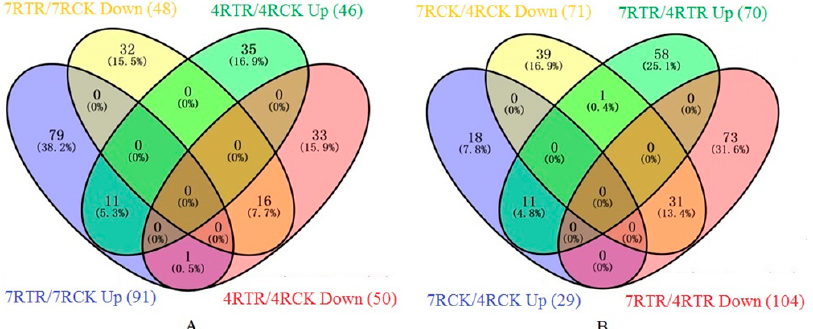
Figure 3. Venn diagrams of the differentially abundant proteins (DAPs) of different comparison groups. ( A ) Venn diagrams of the DAPs between 7RTR and 7RCK as well as those in 4RTR and 4RCK. ( B ) Venn diagrams of the DAPs between 7RTR and 4RTR as well as those in 7RCK and 4RCK. 7RTR/7RCK is the protein abundance ratio of 7RTR to 7RCK, 4RTR/4RCK is the protein abundance ratio of 4RTR to 4RCK, 7RCK/4RCK is the protein abundance ratio of 7RCK to 4RCK, and 7RTR/4RTR is the protein abundance ratio of 7RTR to